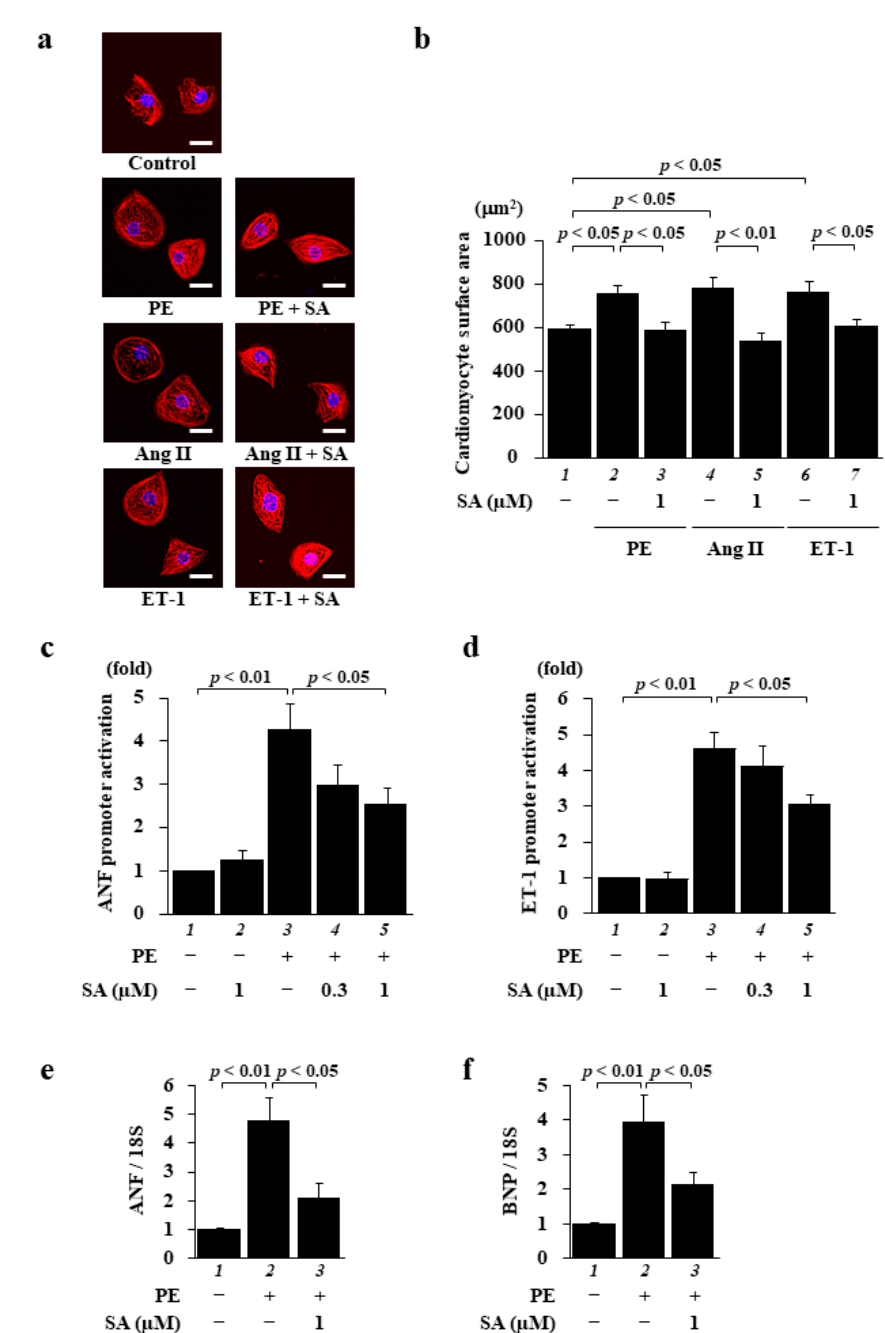
Figure 1. Sarpogrelate suppressed cardiomyocyte hypertrophy induced by a variety of hypertrophic stimuli. Primary cultured cardiomyocytes were treated with 0.3 or 1 µ M sarpogrelate (SA) and then stimulated with 30 µ M phenylephrine (PE), 0.1 µ M angiotensin II (Ang II), or 0.1 µ M endothelin 1 (ET-1) for 48 h. ( a ) Immunofluorescence staining was performed using anti-MHC antibodies and Alexa Fluor 555-conjugated anti-mouse IgG. Scale bar: 20 µ m. ( b ) Cell surface area was measured using NHI ImageJ software. All data are presented as the mean ± SEM of four individual experiments. ( c , d ) Cardiomyocytes were harvested 48 h after stimuli and a luciferase reporter assay was performed for ANF ( c ) and ET-1 ( d ) promoters. Data are presented as the mean ± SEM of five individual experiments. ( e , f ) The mRNA levels of hypertrophy-related gene transcriptions of ANF ( e ) and BNP ( f ) at 48 h after stimulation were examined by quantitative PCR. Data are presented as the mean ± SEM of three individual